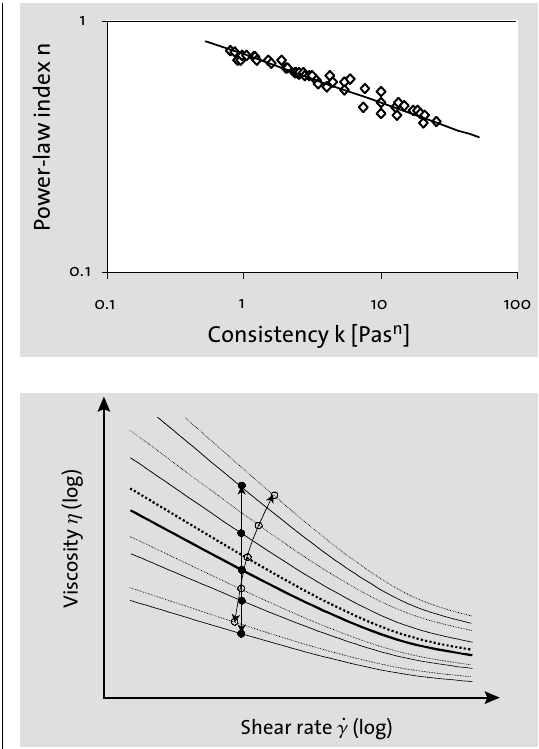
(log). Shear rate g